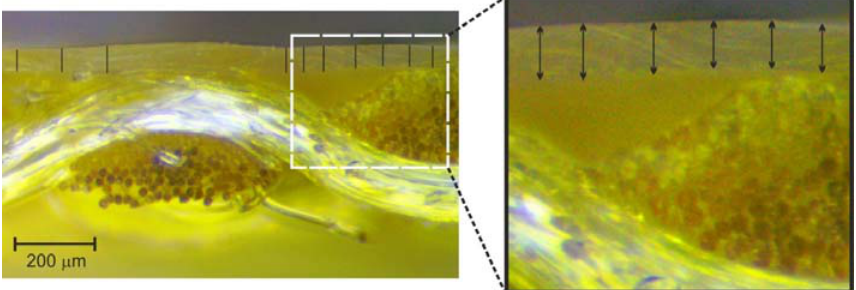
Figure 6. Illustration of the idea of measuring the thickness of a Cordura polyurethane layer in bright ‐ field microscopic images using the line tool of Adobe Photoshop software.